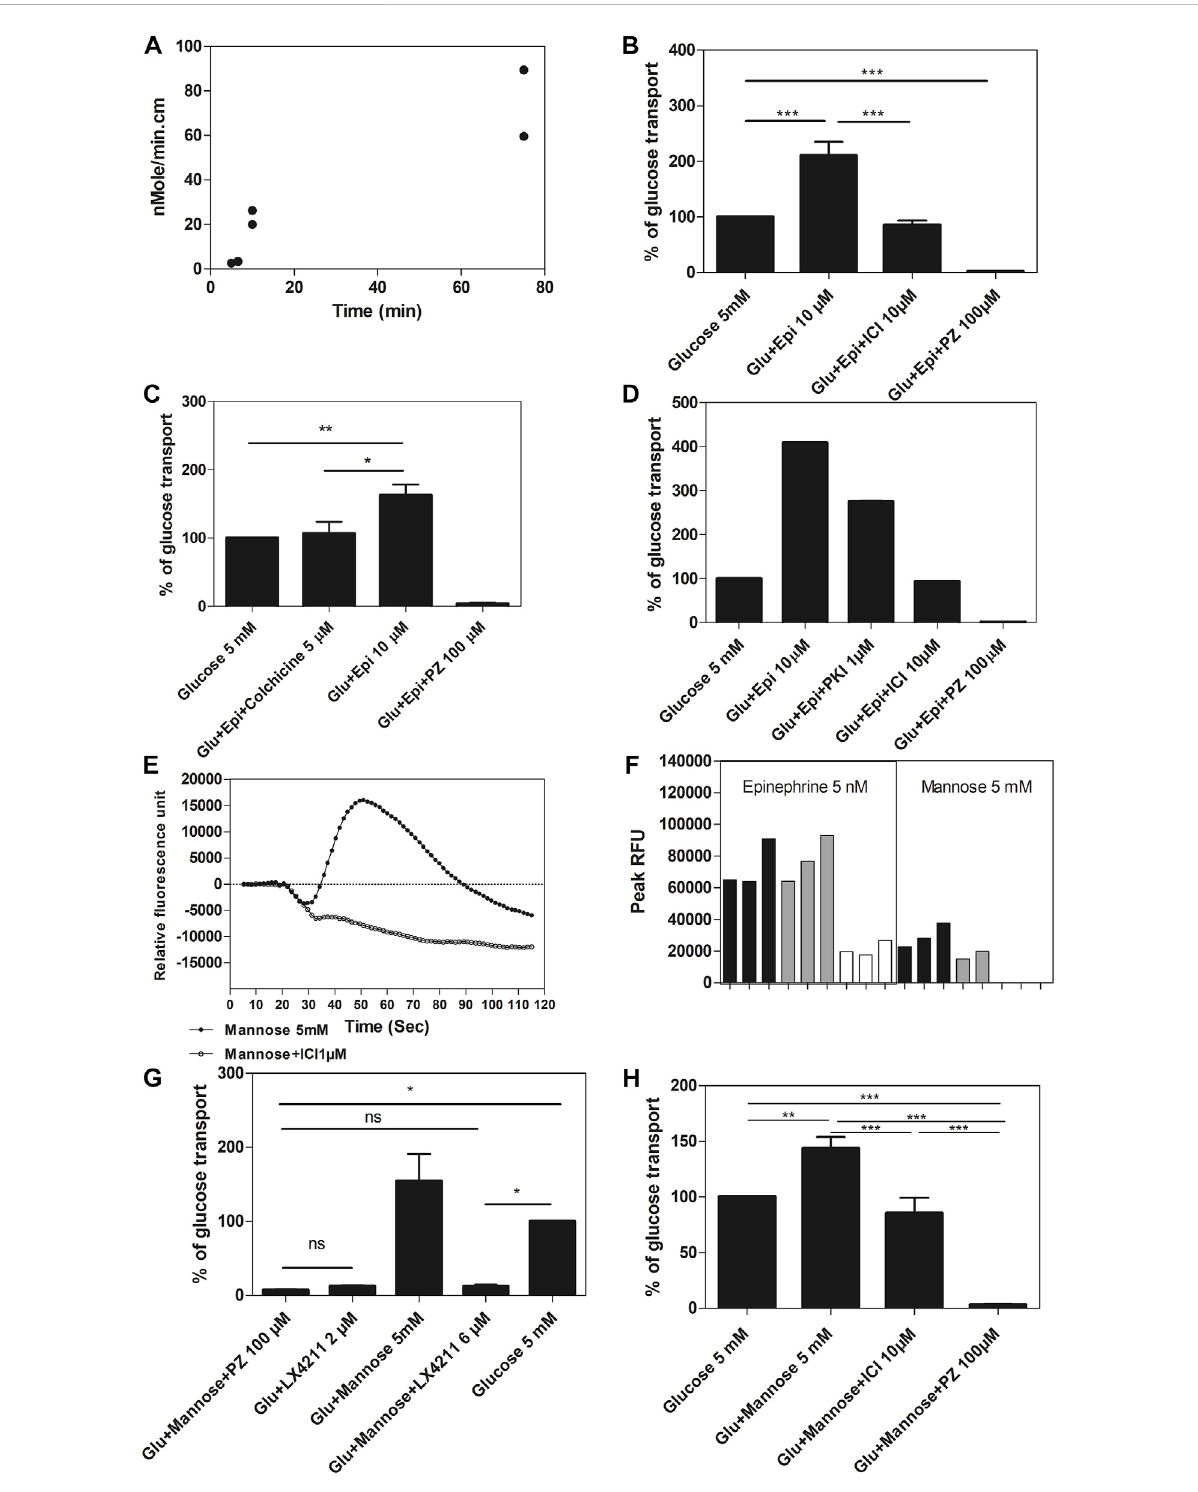
FIGURE 5 Glucose transport in everted sacs prepared from rat intestine. (A) Comparison of the amount of glucose accumulated per min in the everted sacs, prepared from rat intestine ( n = 2; biological replicates), during different time periods (5, 10, and 75 min) after addition of 10 mM glucose. The datarepresentedasindividualreplicates. (B) Effectofepinephrine(Epi),the β 2-speci fi cantagonistICI118,551(ICI)andtheglucosetransportinhibitor phlorizin (PZ) on the level of glucose (Glu) accumulated after 10 min inside everted sacs, prepared from rat intestine. ICI 118,551 blocks